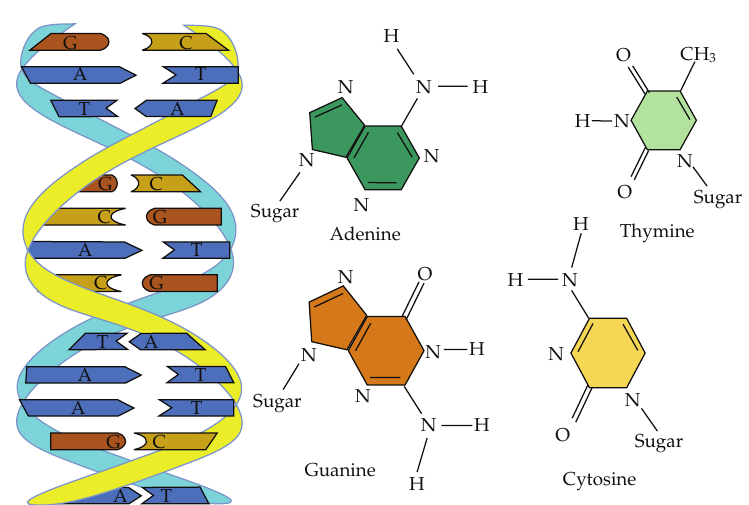
Figure 1: A double-stranded DNA structure diagram.